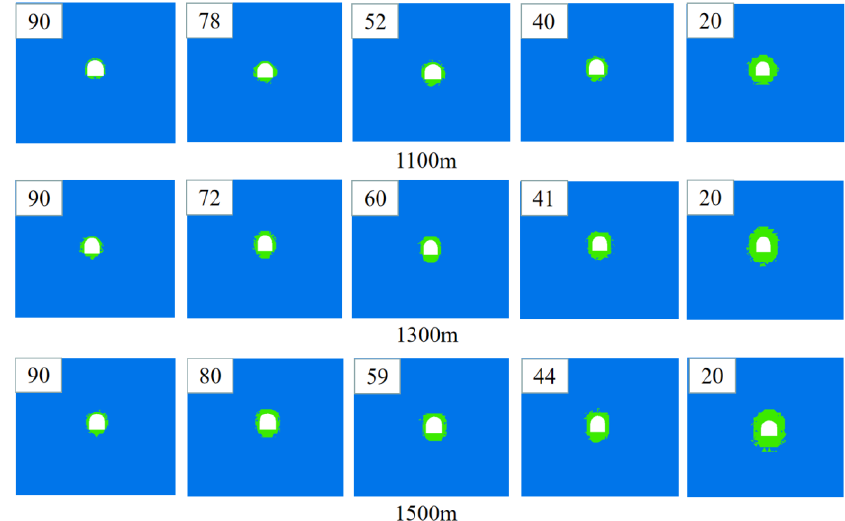
Figure 7. Plastic zone distribution of surrounding rock. Table 5. Plastic zone volume of roadway under different rock mass grades.